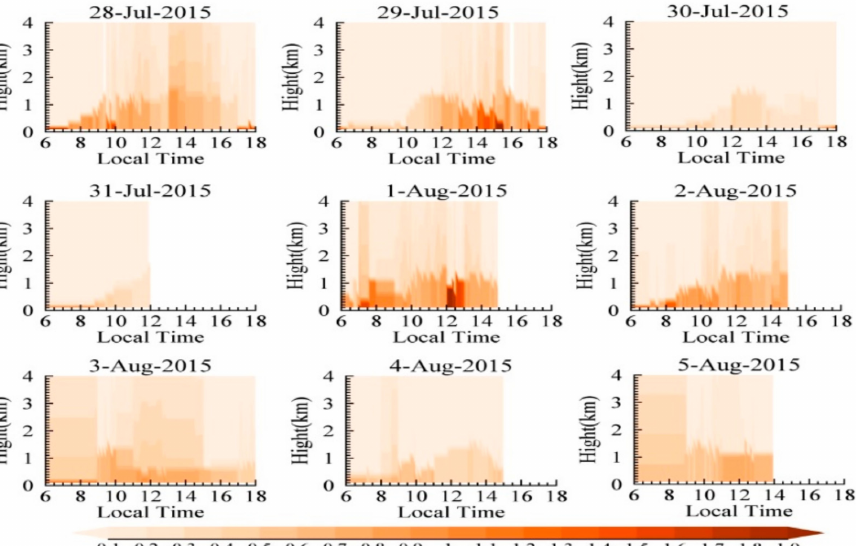
Figure 7. Time series of aerosol extinction coefficient profiles (1~4 km) at 550 nm retrieved from MAX DOAS measurement in Shanghai from 28 July to 5 August 2015 (6:00~18:00 LT).